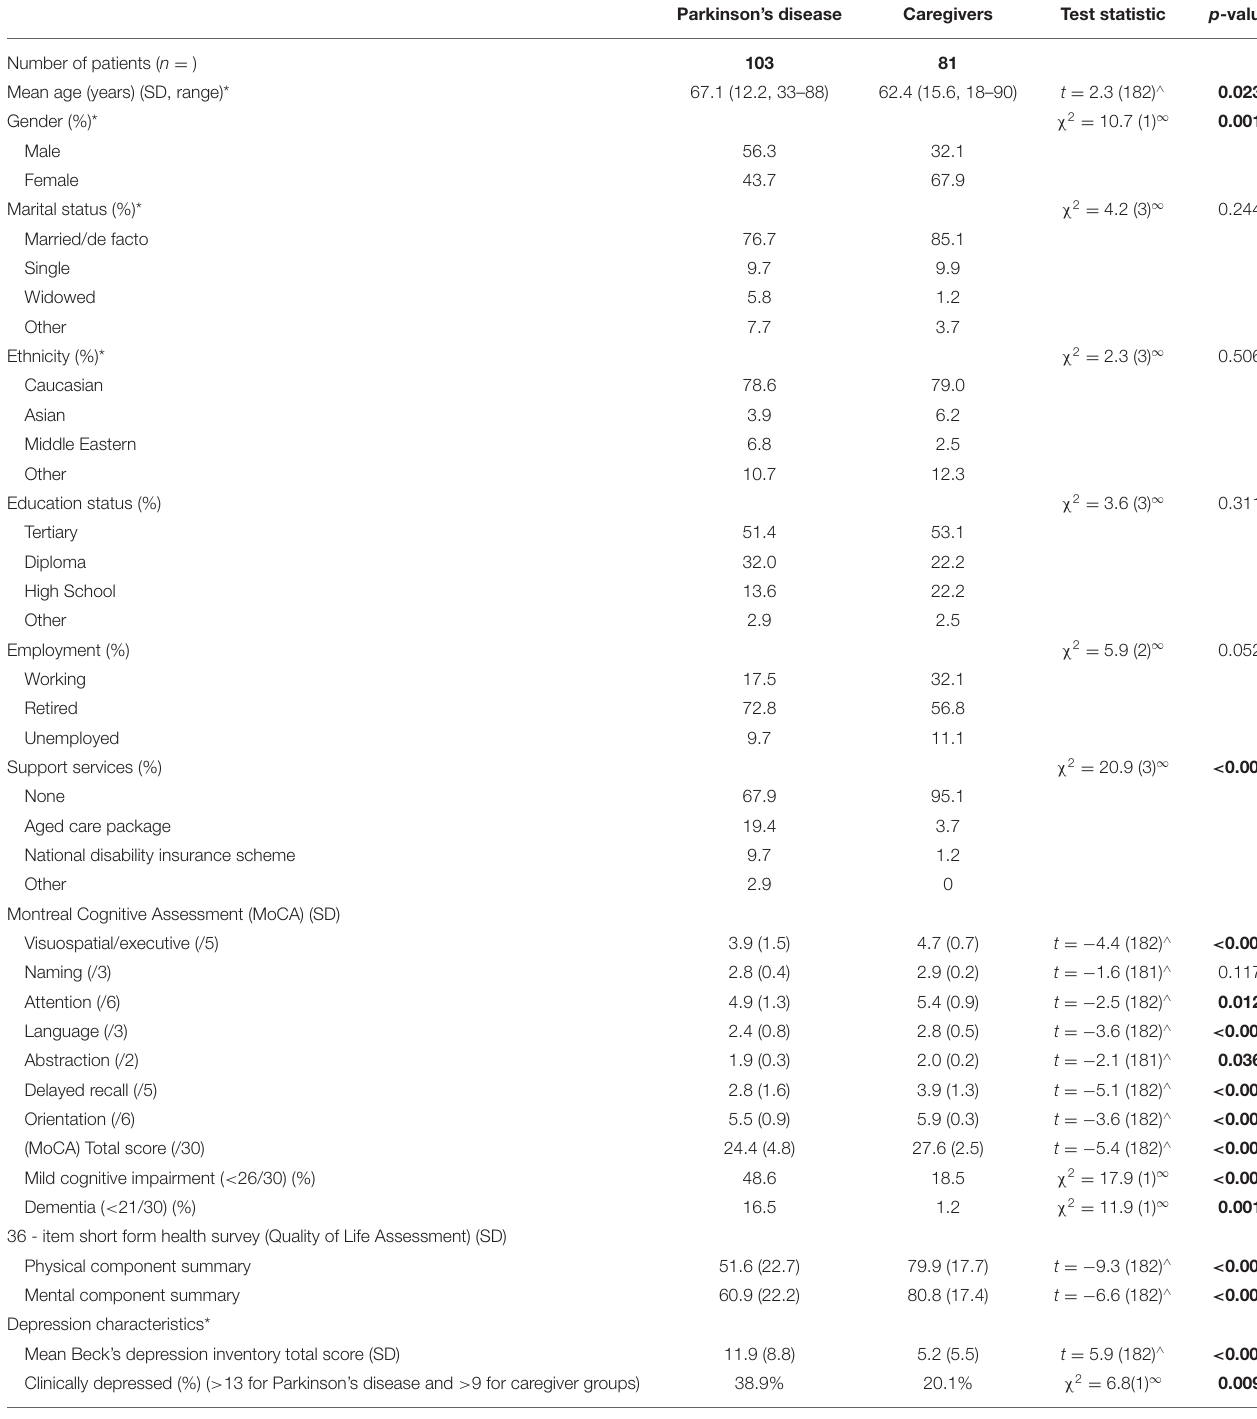
TABLE 1 | Cohort demographic and clinical